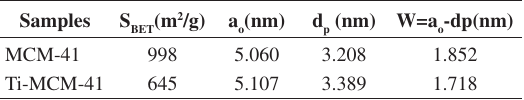
Table 1. Crystallographic parameters obtained by X-ray diffraction and specific area by the BET method for calcined MCM-41 and Ti-MCM-41.